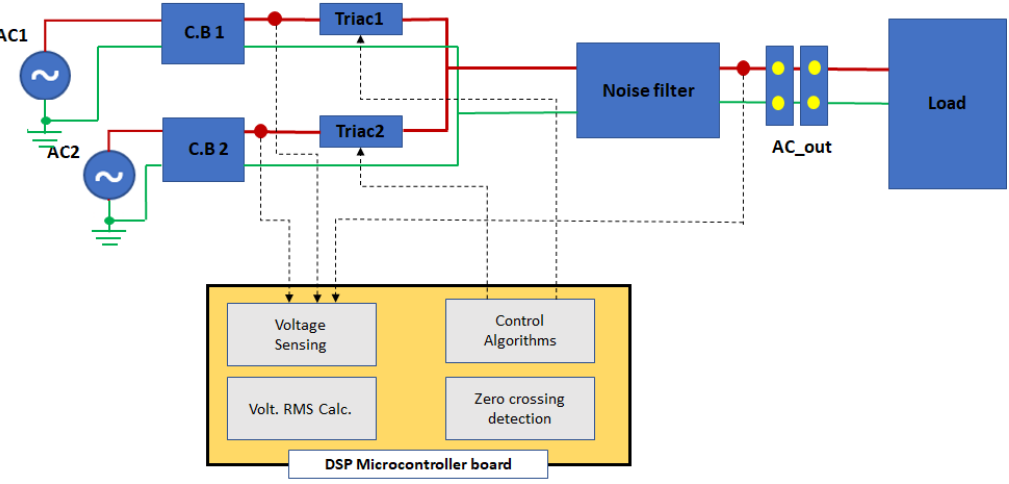
Figure 2. Overall configuration of the proposed two-source switching circuit with an SSTS.